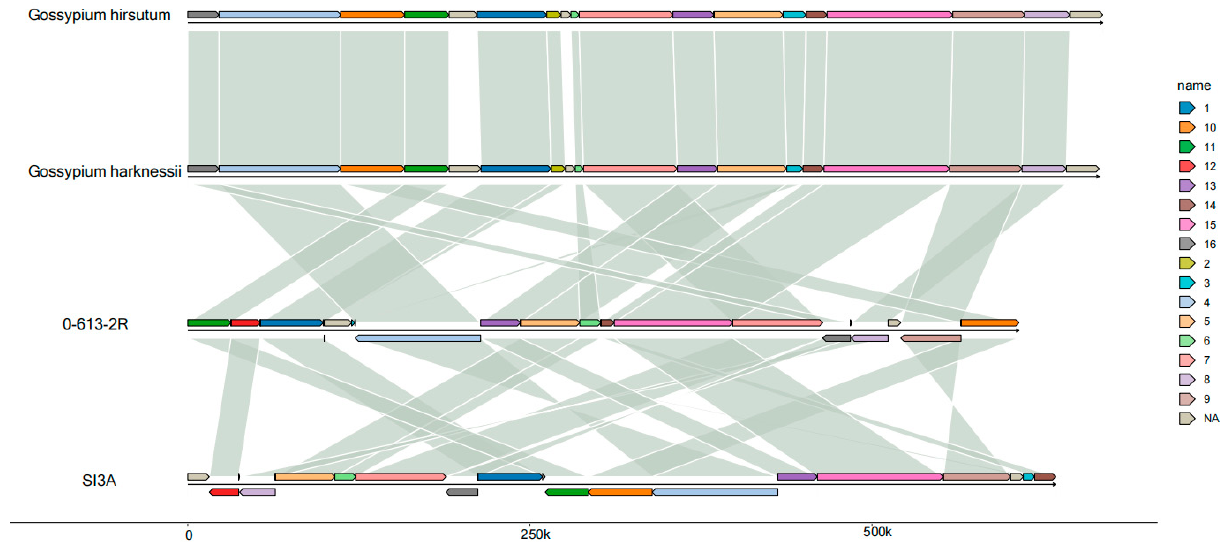
Figure 2. Sequence collinearity analysis of 0-613-2R and SI3A mitochondrial genome with G. hirsutum and G. harknessii mitochondrial genome. Different colors represent different blocks in each mitochondrial genome and the two blocks that are connected by corresponding line indicates high homology between them. Reverse and direct transcript orientation are indicated above and below the central line.